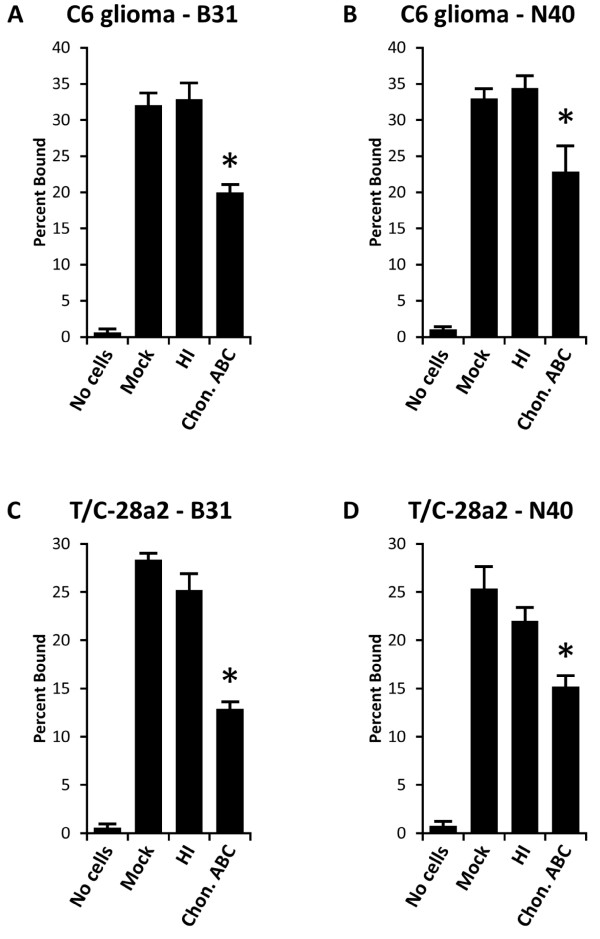
 Binding of B. burgdorferi strains B31 and N40D10/E9 to C6 glioma and T/C-28a2 chondrocyte cell monolayers was significantly reduced on pretreating these cells with chondroitinase ABC but remain unaffected on their pretreatment with heparinase I. The experiments were repeated at least three times using four replicates for each treatment. Each value represents the mean ± SD of quadruplicate samples. Asterisks indicate significant reduction (p < 0.05) in binding percentage relative to mock-treated cells as determined by t-test for pairwise comparison of samples with unequal variance.